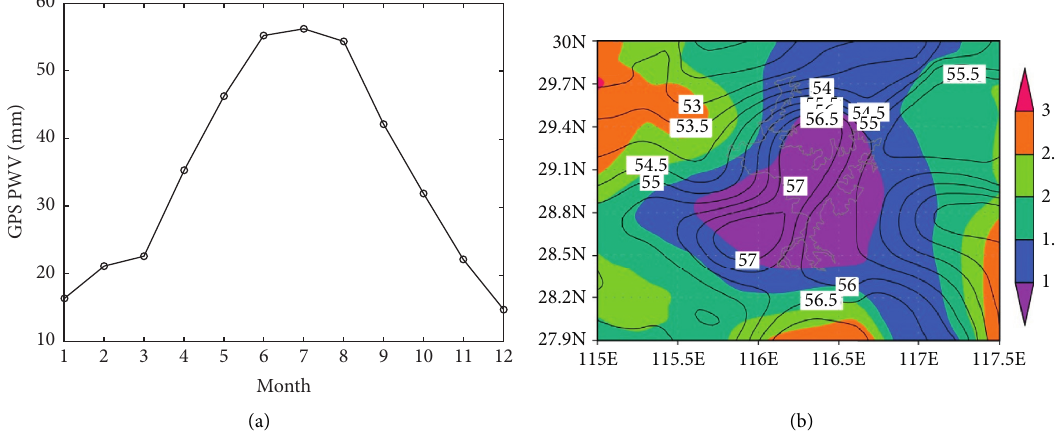
Figure 3: (a) The monthly averaged GPS PWV (mm) over PL from 2015 to 2018. (b) The spatial distribution of GPS PWV (solid lines) and the diurnal variation of the absolute value of the PWV (shadow, unit: mm) over PL at midsummer